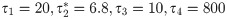
Nullcline Plots of the Pyramidal Neurons Activity, x
1 versus D1 Receptor Activation, d for different values of dopamine releasability, W
34.
W
34 is indicated by the % values relative to 0.36. The solid (open) circles represent stable (unstable) fixed points. The intersection points of the curves are the points of global equilibrium of the system, for that particular W
34. The parameters used here are τ1=20,τ2*=6.8,τ3=10,τ4=800 and W11*=0.5588, W12*=0.786, W
13 = 0.023, W
21 = 0.339, a = 0.15.